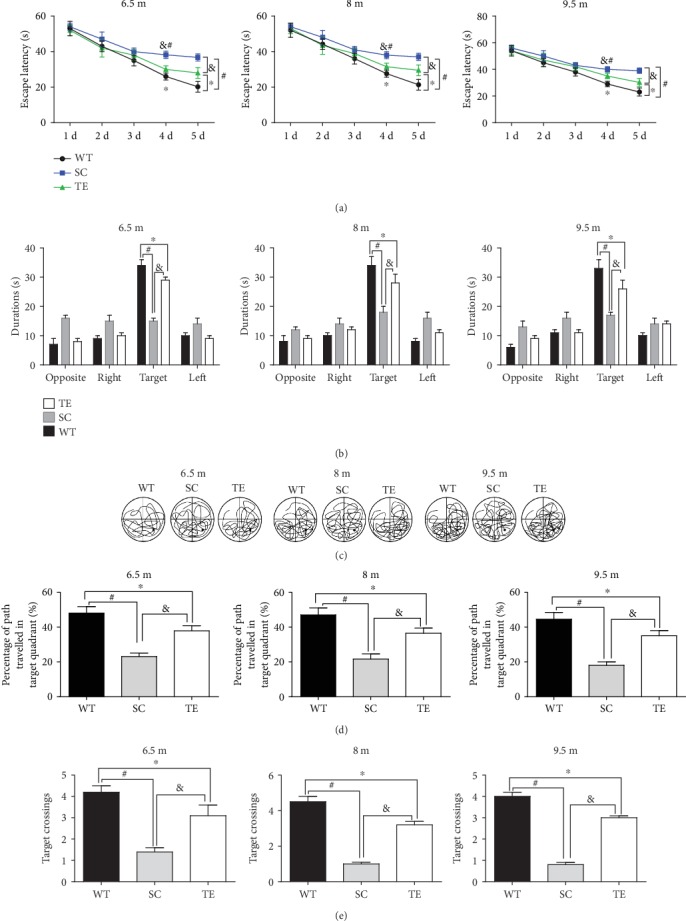
Late 12-week treadmill exercise improved spatial learning and memory in APP/PS1 mice. In the hidden platform test, the escape latencies of WT or APP/PS1 mice over 5 d were recorded (a). In the probe test, the percentage of time spent in the target quadrant (b), typical probe traces (c), percentage of path traveled in the target quadrant (d), and number of target crossings (e) for 6.5 m, 8 m, and 9.5 m WT and APP/PS1 mice with or without exercise and WT mice were compared. WT: wild type; SC: sedentary control; TE: treadmill exercise. ∗WT vs. TE, P < 0.05; #WT vs. SC, P < 0.05; &TE vs. SC, P < 0.05.